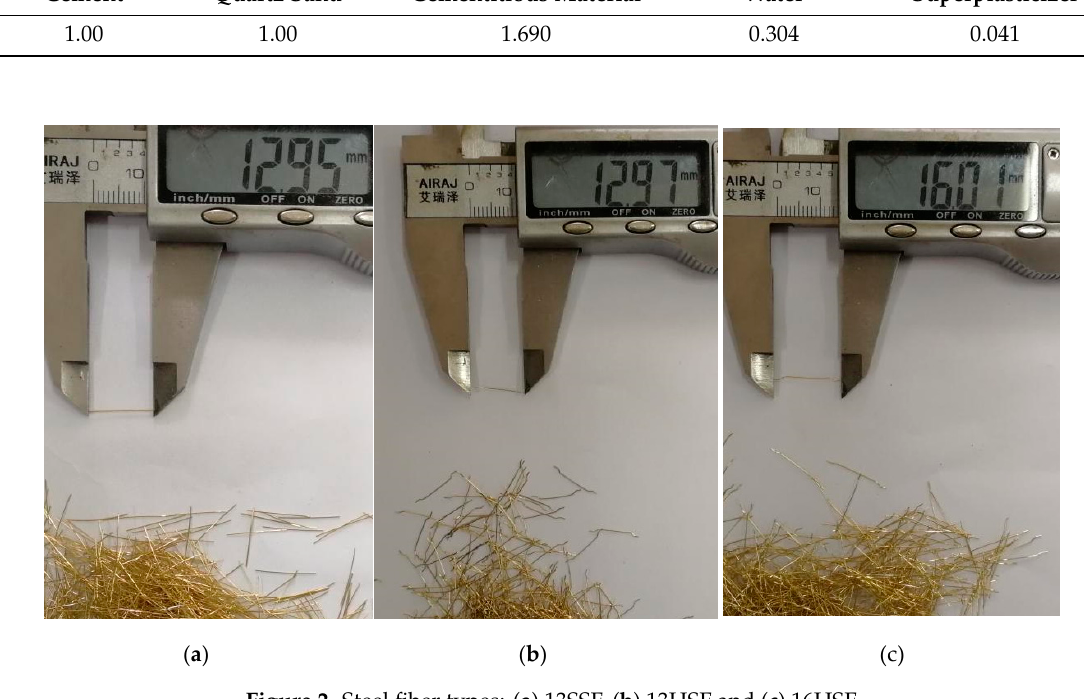
Table 2. Physical and mechanical properties of the steel fibers.